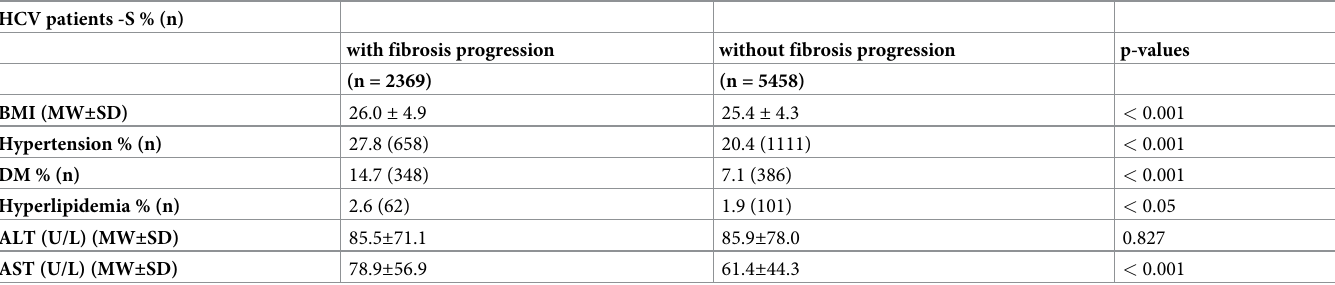
Table 3. Metabolic features in HCV patients -S with and without fibrosis